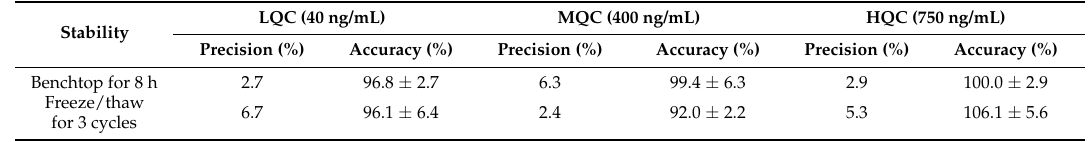
Table 3. Stability of FTS after freeze/thaw and benchtop storage conditions.